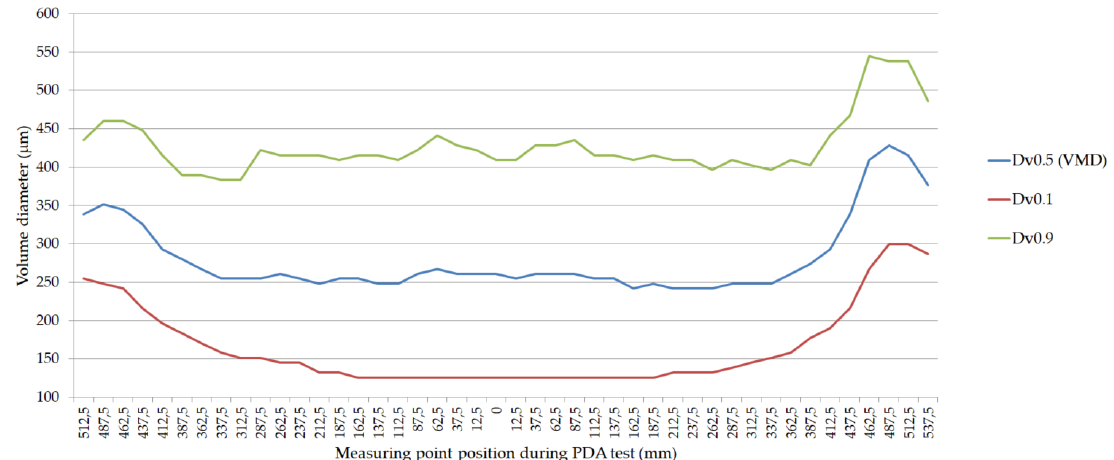
Figure 9. Distribution of volume diameters (Dv0.1, Dv0.5, Dv0.9) at measuring points in the liquid stream for nozzle number 2. Note: Dv0.1, volumetric diameter, below which smaller drops represent 10% of the total volume; Dv0.5, volumetric diameter, below which smaller drops represent 50% of the total volume; Dv0.9, volumetric diameter, below which smaller drops represent 90% of the total volume.